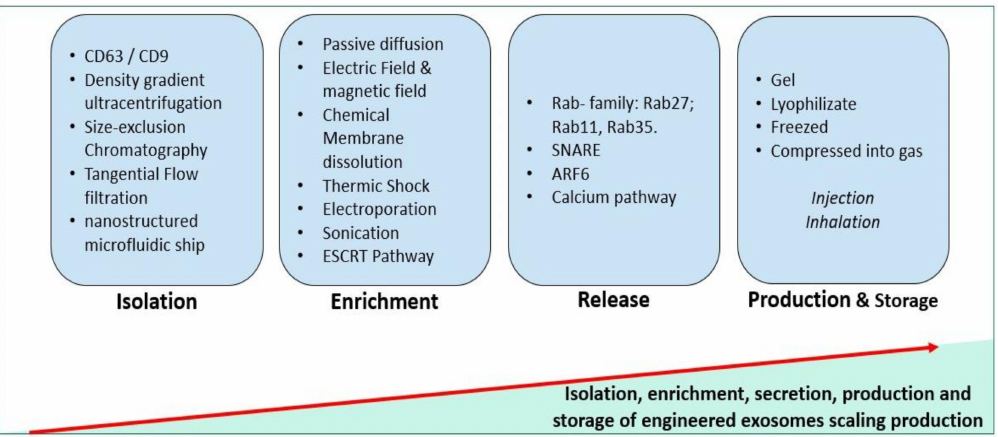
Figure 2. Steps for therapeutic exosome